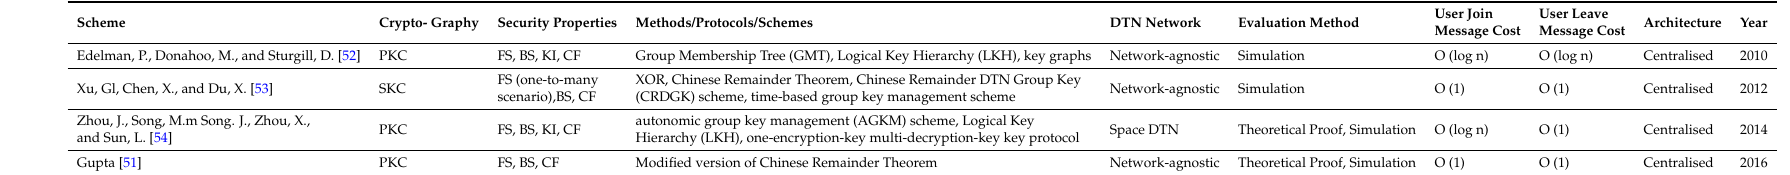
Table 4. Comparison of Group Key Management Proposed Methods.